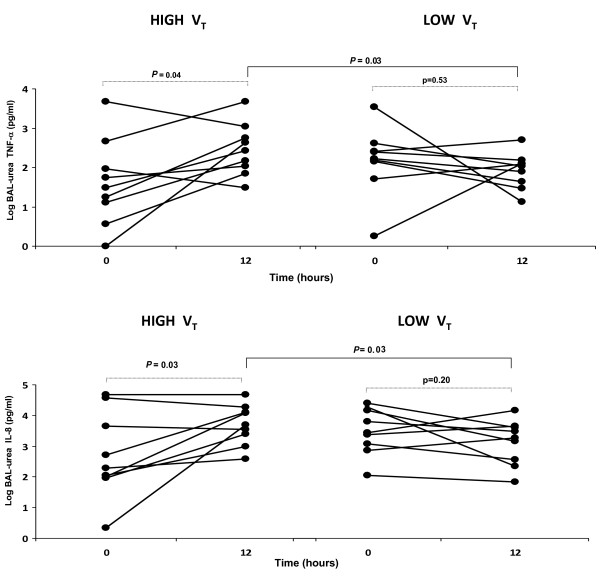
Time course of logarithmic standardized-urea bronchoalveolar lavage (Log BAL-urea) TNF-α (top) and IL-8 (bottom) levels. There were no differences between groups at baseline.